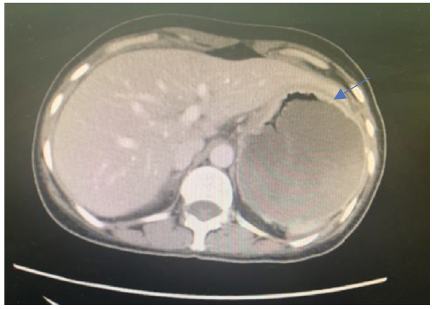
Figure 4: An image of the CT scan of the abdomen and pelvis showing a di ff use gastric wall thickening, about 17mm (blue arrow).